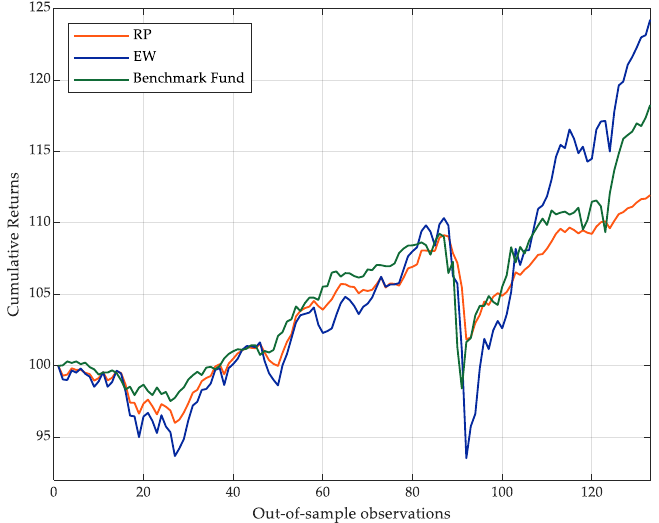
Figure 4. Conventional Portfolio returns (in-sample w = 130; out-of-sample w = 132). Notes to im- prove table clarity, returns were normalised on a scale of